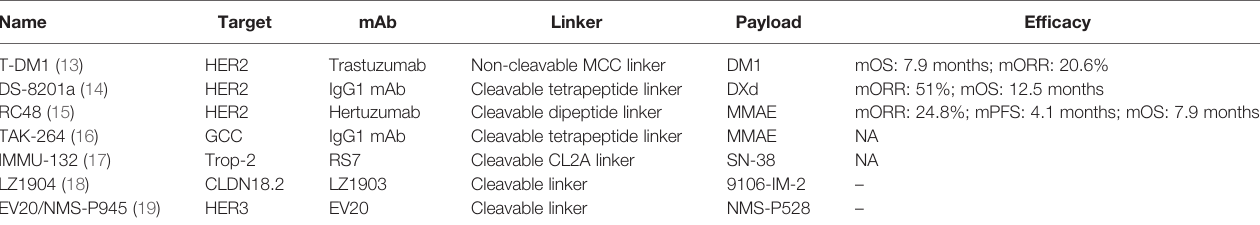
TABLE 1 | Selected ADCs in the